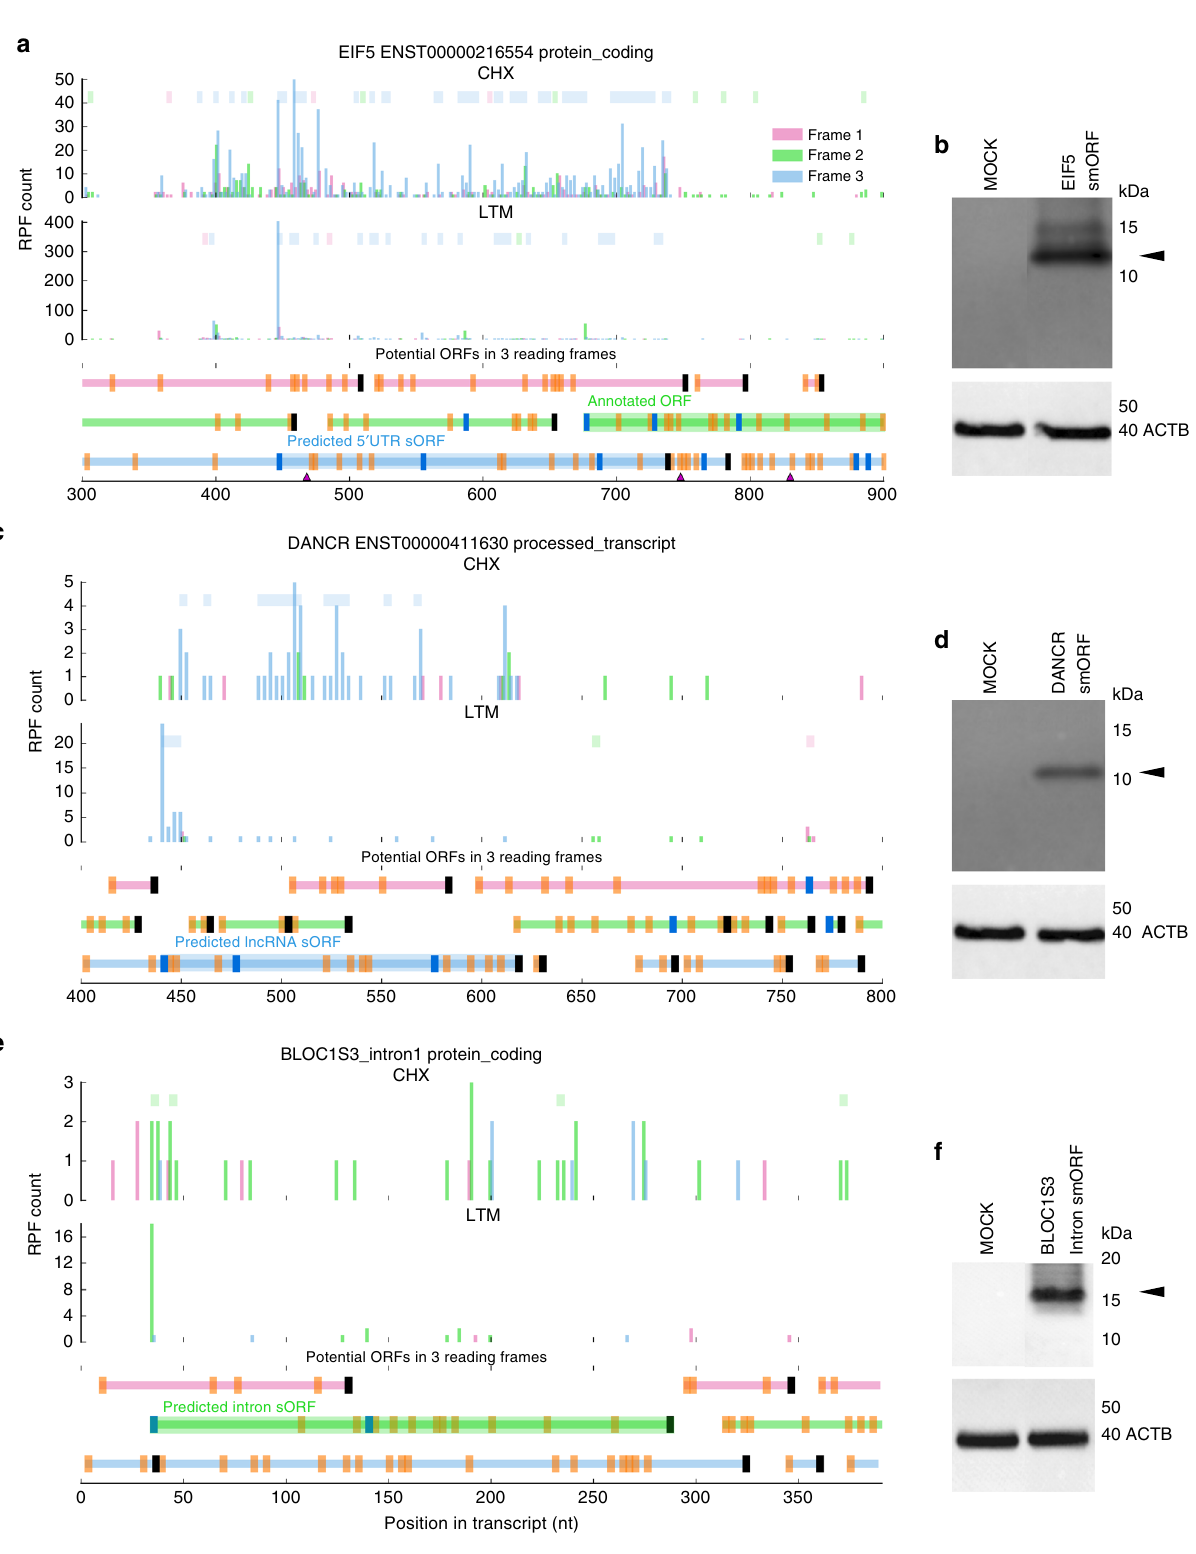
Fig. 6 Experimental validations of the computationally predicted smORFs. a rRibo-seq and LTM-based TI-seq RPF count pro fi les in HEK293 cell line for a predicted uORF in 5 ′ UTR of EIF5 . b FLAG-tagged uORF within the context of the host mRNA was ectopically expressed and translation of the predicted polypeptide was detected by western blot with an anti-FLAG antibody. β -actin protein was used as internal control for western blot analysis. c rRibo-seq and LTM-based TI-seq RPF count pro fi les for a predicted ORF encoded by lncRNA DANCR . d FLAG-tagged smORF within the context of host lncRNA was ectopically expressed and translation of the predicted polypeptide was detected by western blot with an anti-FLAG antibody. e rRibo-seq and LTM-based TI-seq RPF count pro fi les for a predicted ORF encoded by an intron of BLOC1S3 . f FLAG-tagged intronic smORF within the context of the host mRNA was ectopically expressed and translation of predicted polypeptide was detected by western blot with an anti-FLAG